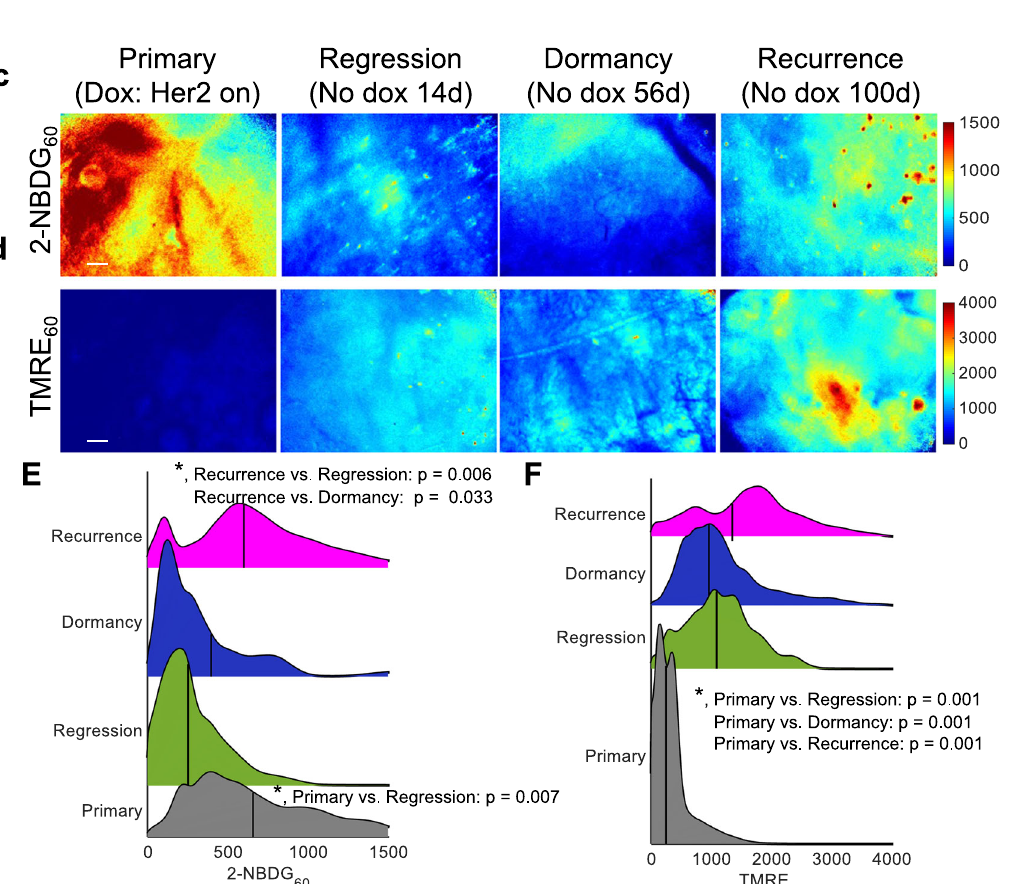
Fig. 2 Following oncogene ablation, slowly recurring tumors showed both increased glucose and mitochondrial metabolism, over the course of regression, dormancy, and recurrence. 2-NBDG and TMRE uptake 60 min post-injection were measured in mammary tumors overexpressing the oncogene Her2 ( + dox) and mammary tumors in which Her2 was downregulated via dox withdrawal. Recurrent tumors spontaneously re-grew ~90 days following Her2 downregulation. a Normalized average tumor volumes during the dormancy cycle where 0 days represents primary tumors (Her2 on). Error bar = standard error of the mean, ( n = 11). b Representative immunohistochemistry images stained Ki67 (top, proliferation) CC3 (bottom, apoptosis) (brown). c , d Representative 2-NBDG 60 ( c ) and TMRE 60 ( d ) images in a primary mammary tumor on dox (Her2 on) ( n = 10), during regression ( – No dox 14 days) ( n = 10), during dormancy (No dox 56 days) ( n = 8), and during recurrence (No dox 100 days) ( n = 9). e 2-NBDG 60 probability density functions (PDFs) across all pixels and all mice at each time point. f TMRE 60 probability density functions (PDFs) across all pixels and all mice at each time point. Vertical lines superimposed on PDF curves report the average fl uorescence. Statistical comparisons were performed using a KS